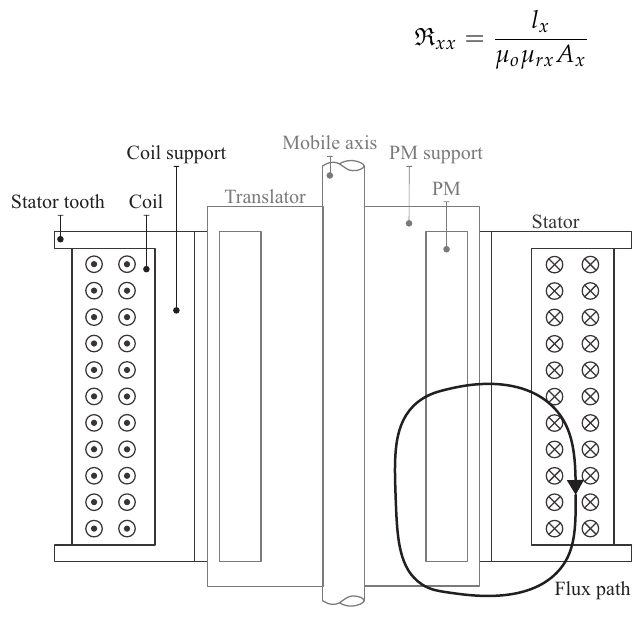
Figure 4. Schematic design of the linear generator. Figure based on